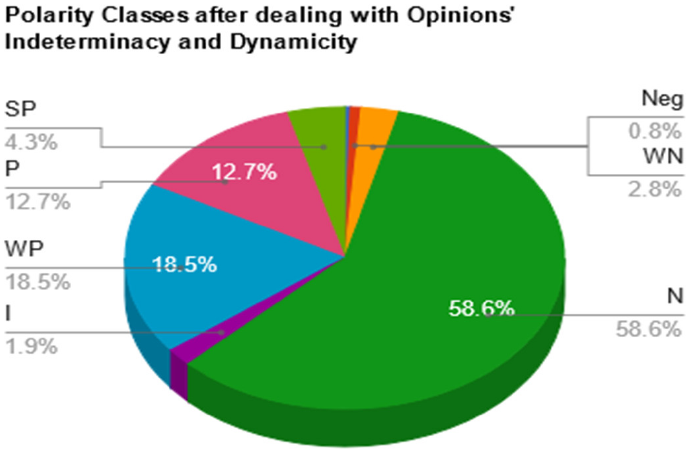
Figure 12. The final polarity classification using the proposed model.